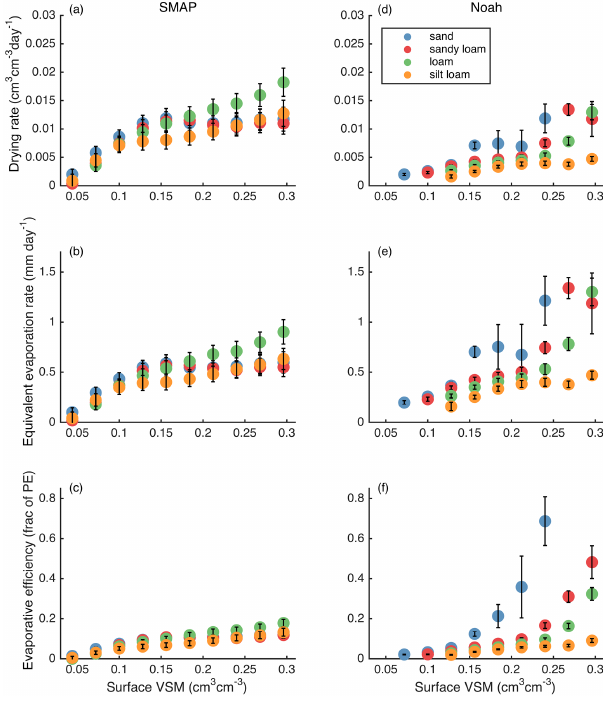
Figure 9. As in Fig. 7, but drying rates are a function of NDVI (eight quantiles, on x -axis) and surface soil moisture content (three quantiles, by color).